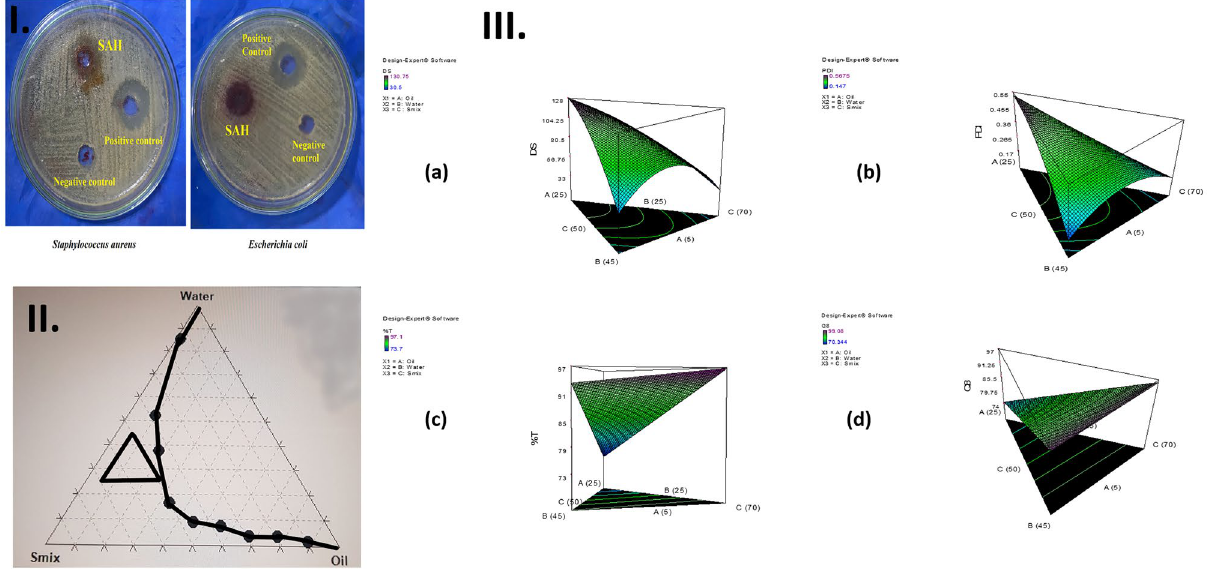
Figure 2. ( I ) Growth inhibition zones of Staphylococcus aureus ATCC (6358) and E. coli ATCC (25,923) caused by SAH, compared to the positive control (Doxycycline) and the negative control (DMSO), ( II ) Pseudo- ternary phase diagram of oils (Maisine and Capryol 90, in ratio 1:1), Surfactant/CoSurfactant mixtures (Smix) (Cremophore EL/Transcutol, in ratio 2:1), and water. The defined percentages of the oils (5–25%), water (25– 45%), and the Smix (50–70%) are represented by the black triangle, and ( III ) 3D surface plots demonstrating the effect of the independent variables; the oil (X1), the water (X2), and the S mix (X3) on ( a ) Droplet size in nm (DS), ( b ) Polydispersity index (PDI), ( c ) % Transmittance, and ( d ) The cumulative percent of SAH released in 8 h (Q 8 ).